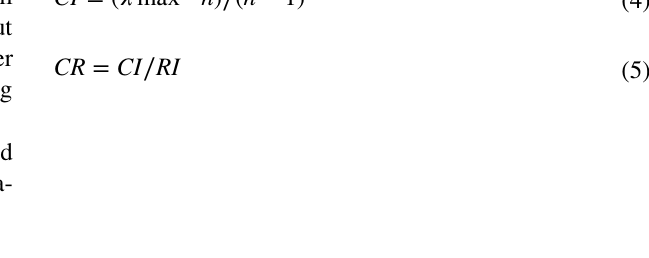
Table 5 Summary of the criteria classification used for the AHP